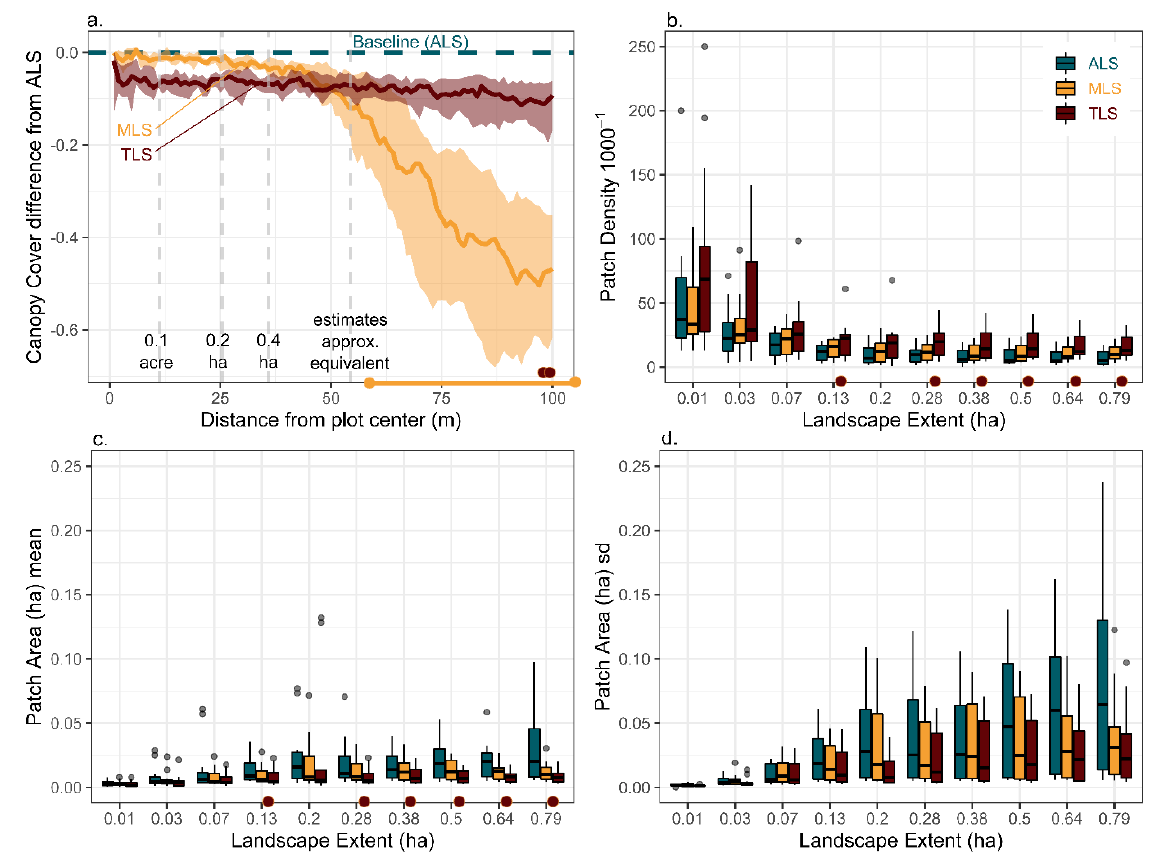
Figure 7. Stand-level landscape metrics illustrating ( a ) mean deviation in mobile laser scan- (MLS; orange) and terrestrial laser scan-derived (TLS; dark red) estimates of canopy cover as compared to airborne laser scan-derived estimates (ALS; dashed blue line) for extents with increasing distance from plot center and boxplots depicting ( b ) patch density, ( c ) mean and ( d ) standard deviation in patch area as observed at increasing extents from plot center. Kruskal-Wallis Rank Sum tests of differences depicted by colored dots indicating where significant differences were found.